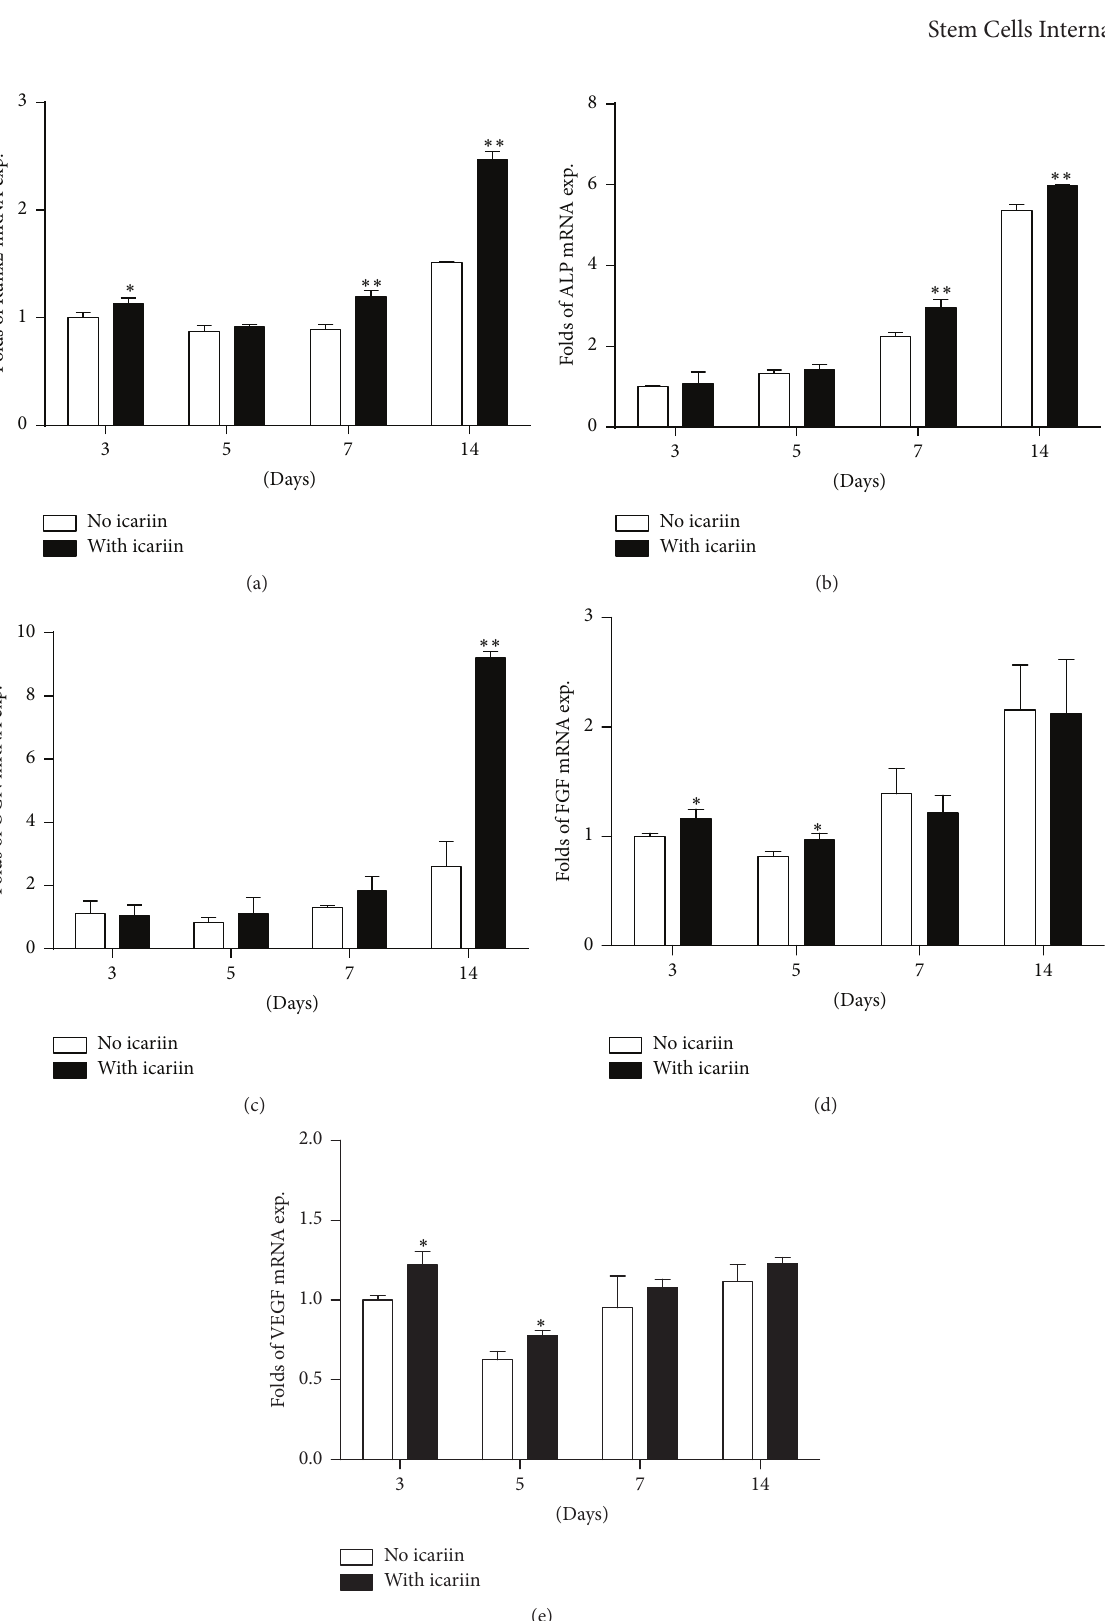
Figure 3: Graphs depicting the fold changes of the expression of osteogenesis-related and angiogenesis-related mRNA in BMSCs under the stimulation of icariin for 3 days, 5 days, 7 days, and 14 days. (a) Runx2, (b) alkaline phosphatase (ALP), (c) osteocalcin (OCN), (d) fibroblast growth factors (FGF), and (e) vascular endothelial growth factor (VEGF). All data are presented as mean values together with the standard deviation (SD). ∗ 𝑝 < 0.05 ; ∗∗ 𝑝 < 0.01 indicating the statistical difference between the experimental group (with icariin) and the control group (no icariin) at the same time